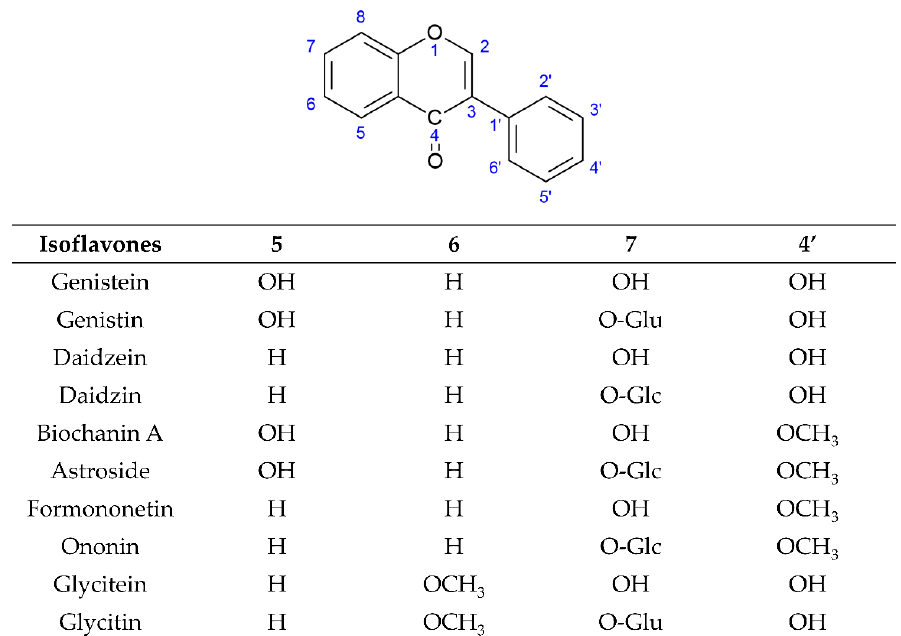
Figure 1. Core structures of flavonoids and isoflavonoids.